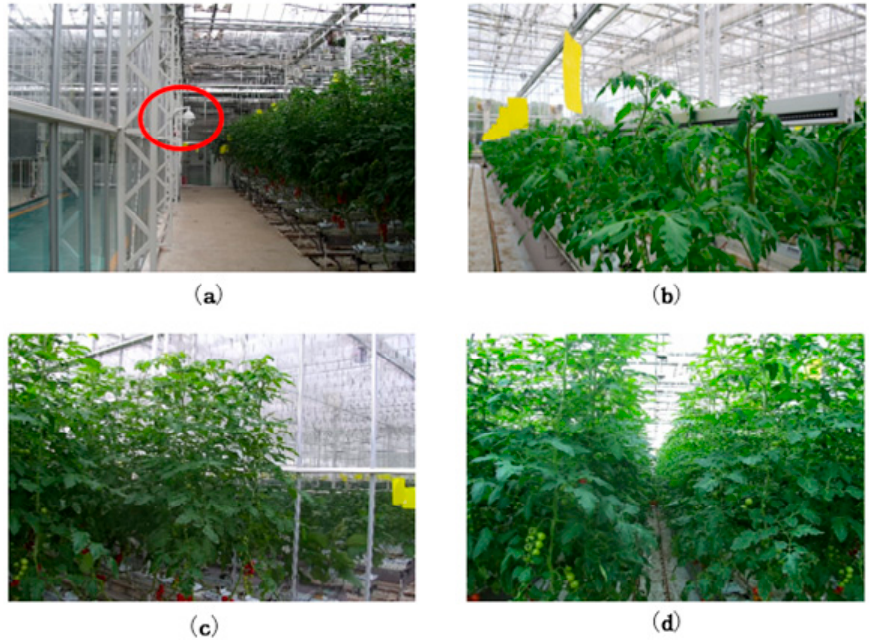
Figure 15. The greenhouse environment. ( a ) The installation site of our fixed camera; ( b – d ) different growth stages and shooting angle of tomato plants.